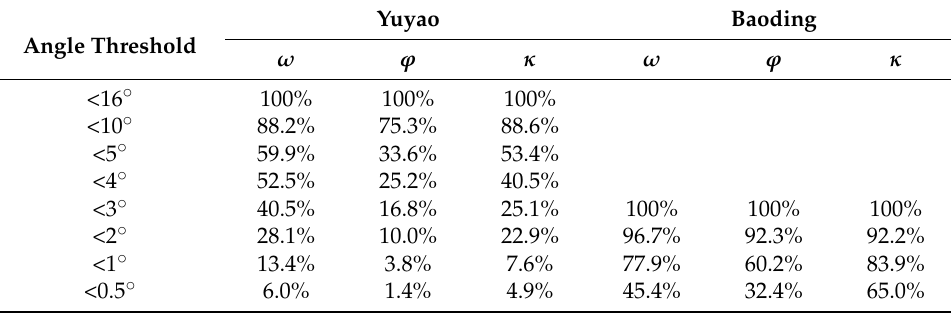
Table 8. Statistical results of rotation angles for Yuyao and Baoding. Yuyao Angle Threshold